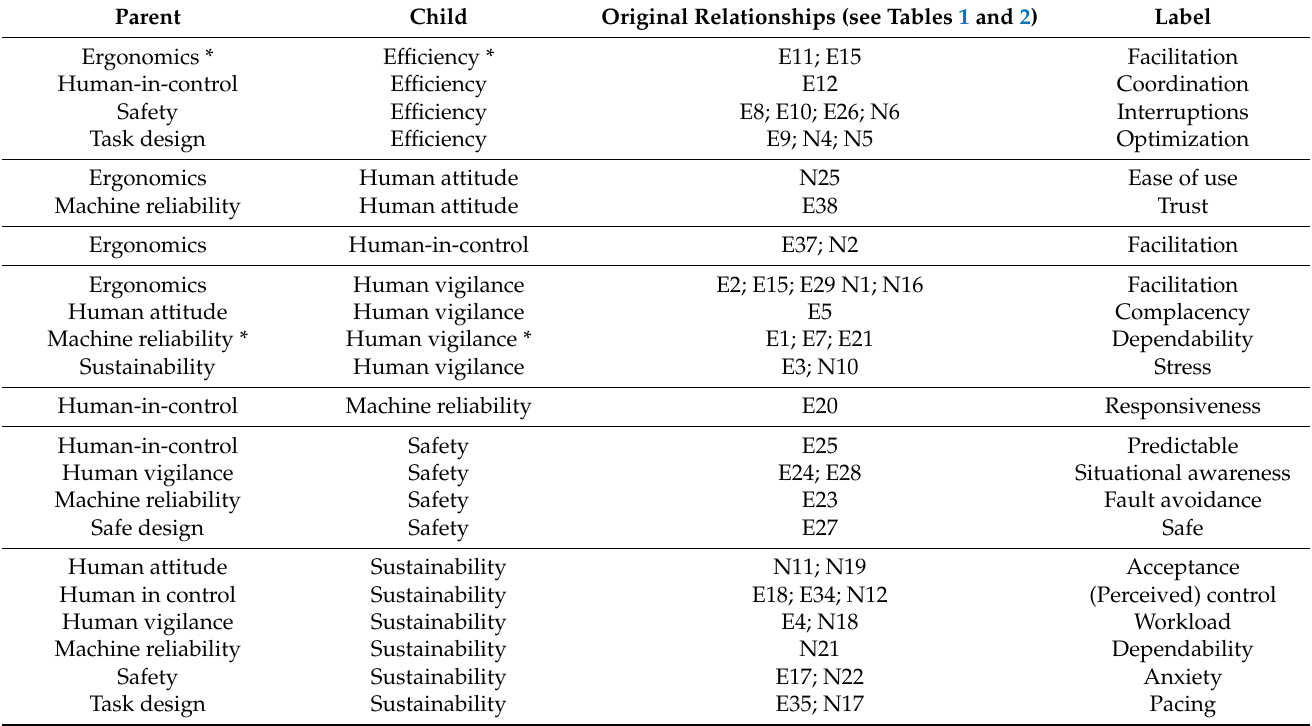
Table 4. Relationships in the final model.